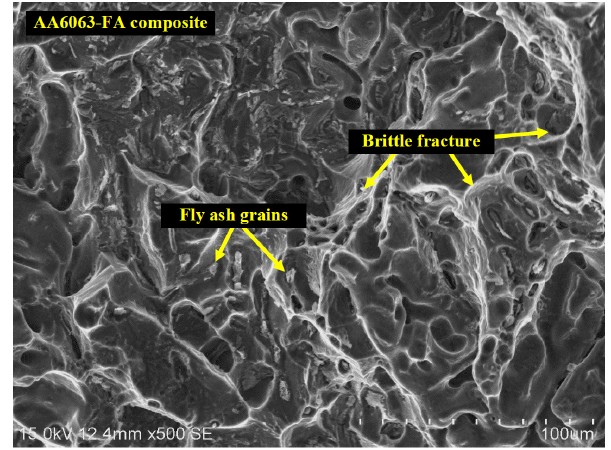
Figure 11. VP ‐ SEM fractography of pure casted AA6063 alloy without added fly ash.